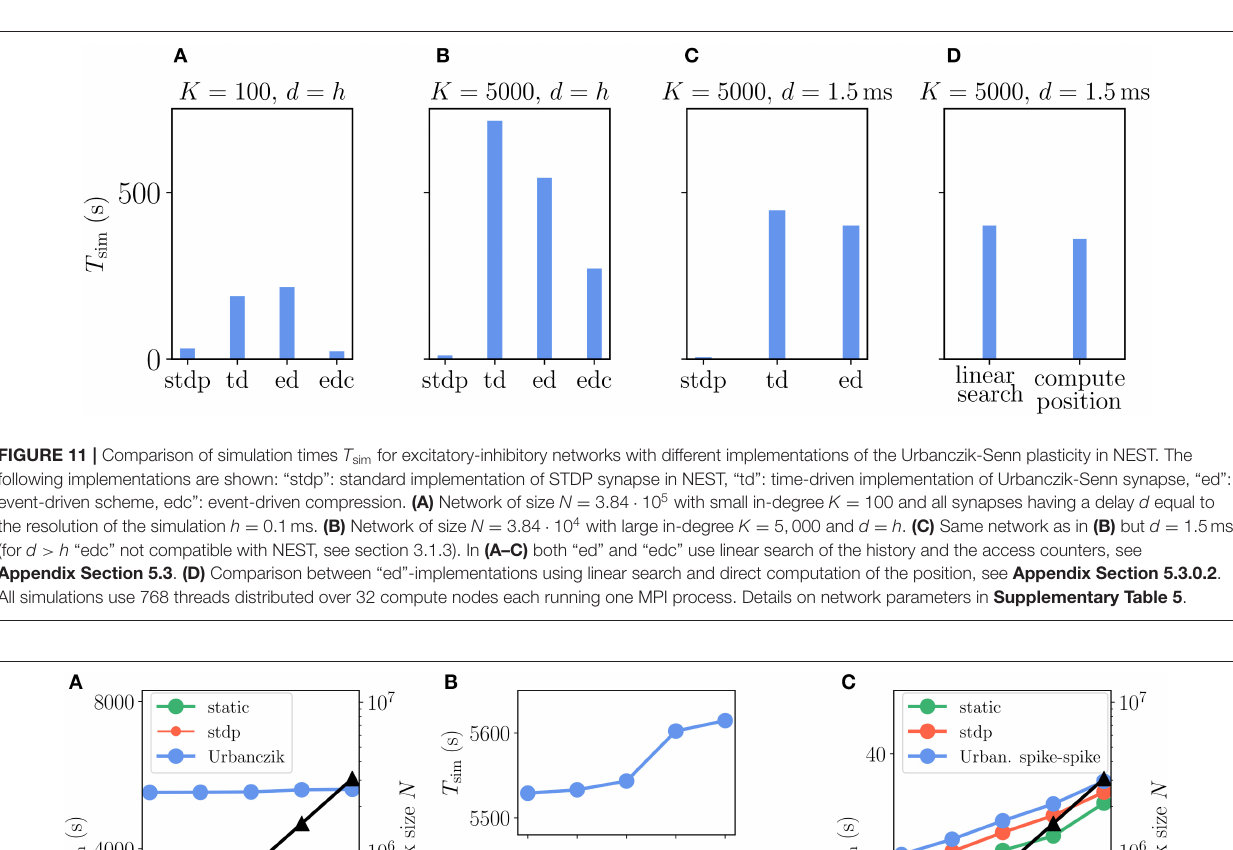
normalization of synaptic weights. The corresponding technical details can be found in Kunkel (2015, ch.